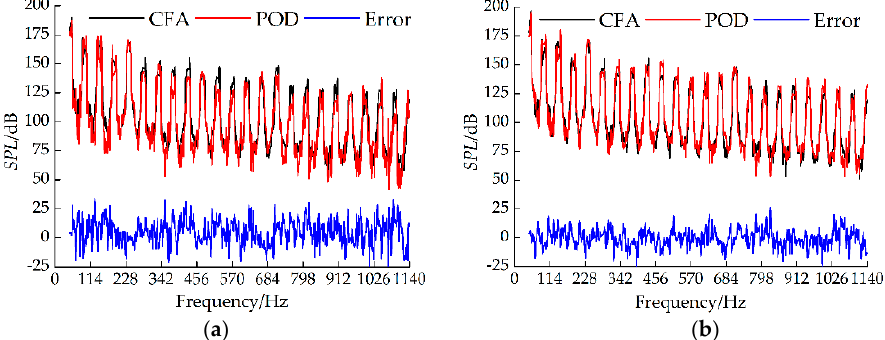
Figure 17. The POD reconstruction, CFA calculation, as well as their error curves of impeller-induced hydrodynamic noise at outlet monitoring point. ( a ) Reconstruction using pressure surface data; ( b ) Reconstruction using suction surface data.